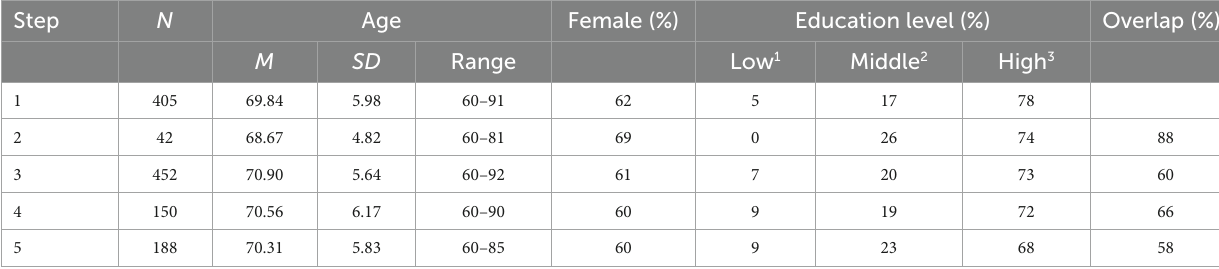
TABLE 1 Descriptive statistics of participants in steps